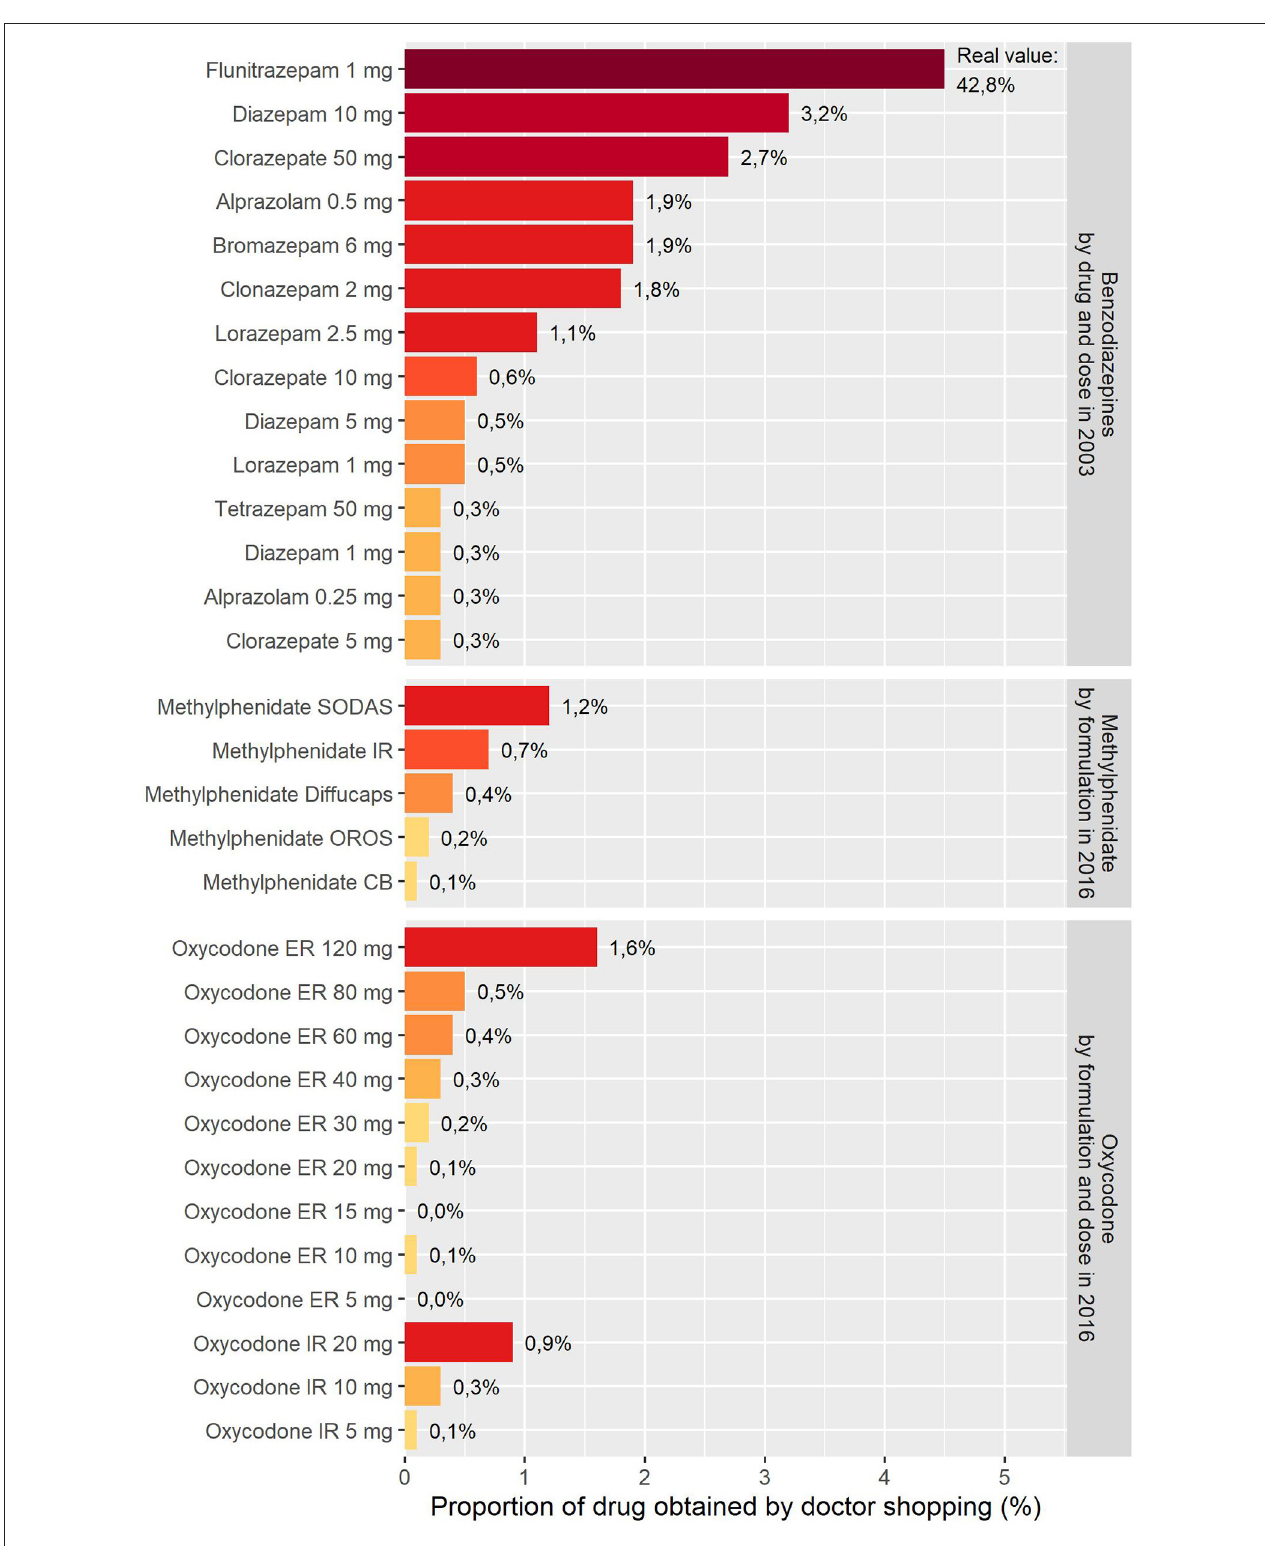
FIGURE 3 | Validation of doctor shopping as a pharmacological tool through its ability to rank prescription drugs within a pharmacological class known for abuse (e.g., benzodiazepines) and recover pharmacological determinants of abuse (e.g., formulation for methylphenidate and dose for oxycodone). SODAS: Spheroidal Oral Drug Absorption System; IR: Immediate-release; OROS: Osmotic-Controlled Release Oral Delivery System; CB: Coated beads. See Table 1 in Soeiro et al. (45) for details on formulations.